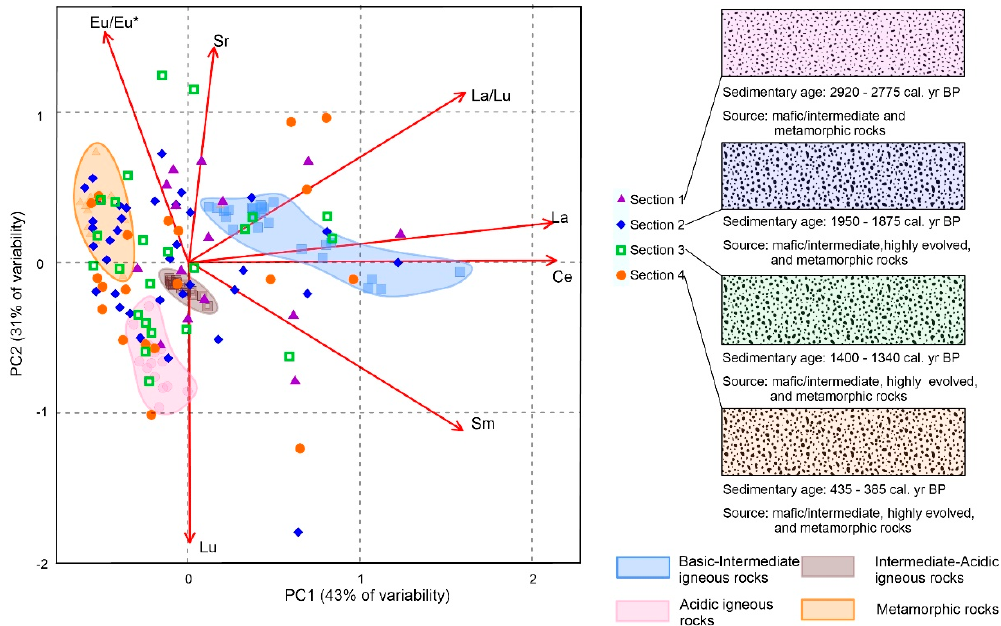
Figure 8. Biplot of the principal component analysis [81] results of apatite compositions in the four sections of Core S3 from the SOT compared to apatite data in different types of bedrock from the literature [28,70,76,82]. The principal component 1 (PC1) vs. PC2 plot explained >74% of the variability in the data. The vectors (red arrows) point in the direction most similar to the variability in element contents and ratios [23,80]. Apatites in more mafic rocks are generally enriched with LREEs and depleted in HREEs [20,67,82], and are hence “pulled” toward the La / Lu, La, and Ce vectors [80]. Apatites in acidic rocks (e.g., S-type granite) are characterized by flat REE patterns, extremely negative Eu anomalies, and low Sr contents [28], which “push” apatite data away from the La / Lu, Sr, and Eu / Eu* vectors and toward the Lu (HREE) vectors [80]. Apatites in metamorphic rocks (e.g., metapelite and metabasite) are characterized by high Sr contents, flat or positive Eu anomalies, and low REE contents [70]; thus, metamorphic apatites are “pulled” toward the Sr and Eu / Eu* vectors and “repelled” by the REE vectors [80]. Apatites in intermediate–acidic rocks (e.g., dacite) are usually scattered near the beginning point of the vectors.